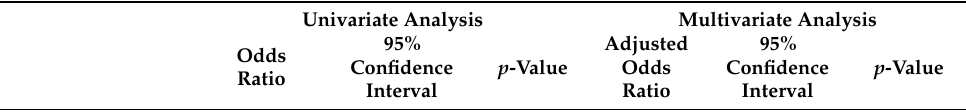
Table 5. Multivariate regression estimates of corresponding author gender among prevalence studies of intimate partner violence (IPV) during pregnancy and prevalence of gestational diabetes mellitus (GDM) included.